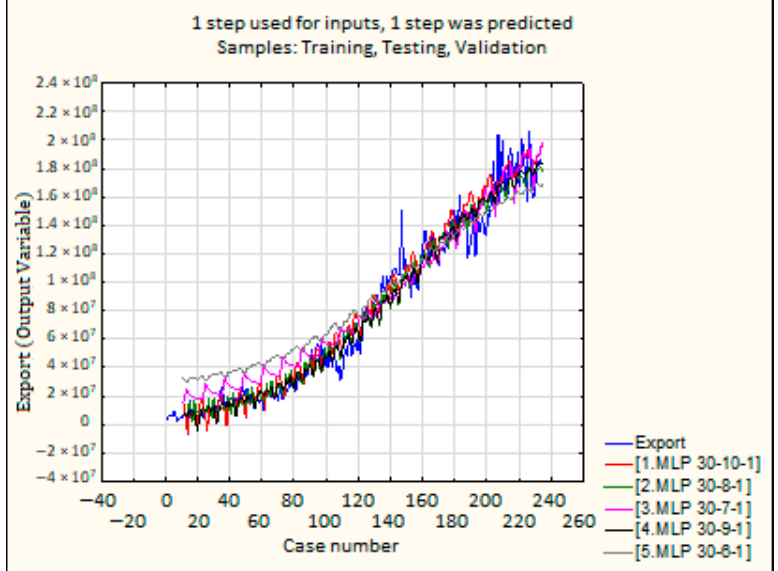
Figure 6. Equalized time series for retained networks (Experiment 3). Source: